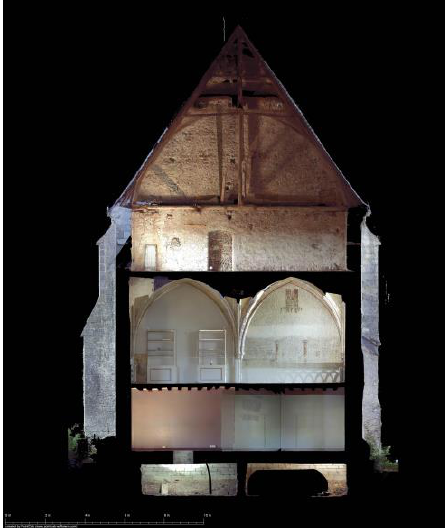
Figure 6. Section south of the